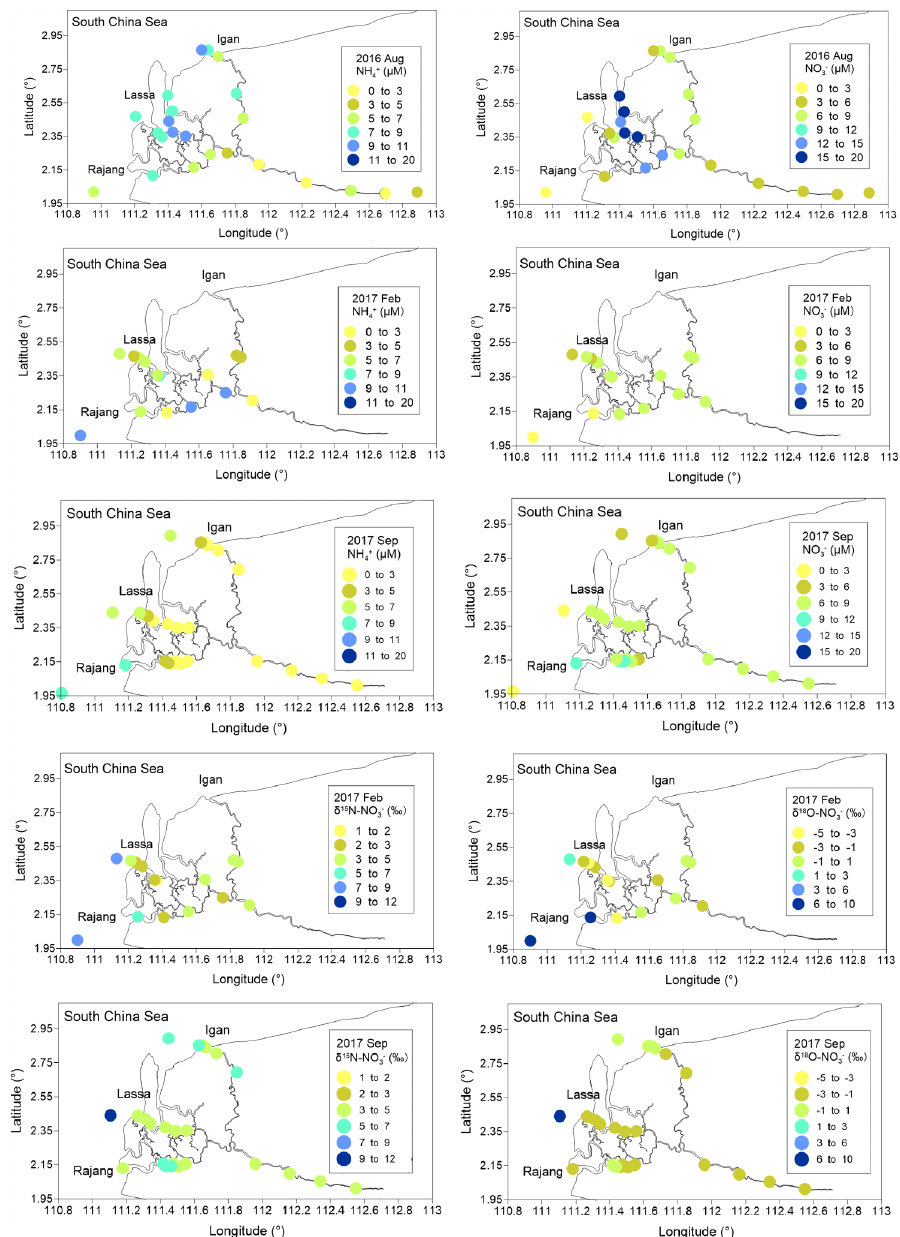
Figure 3. Concentrations of NH + adjacent coastal